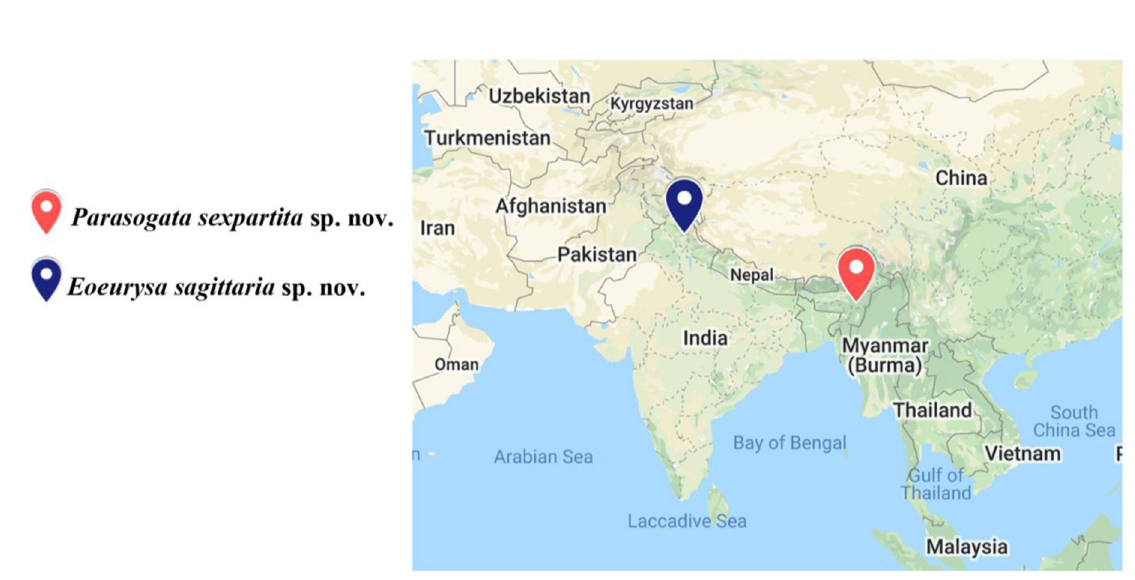
Fig. 6. Distribution map of the new